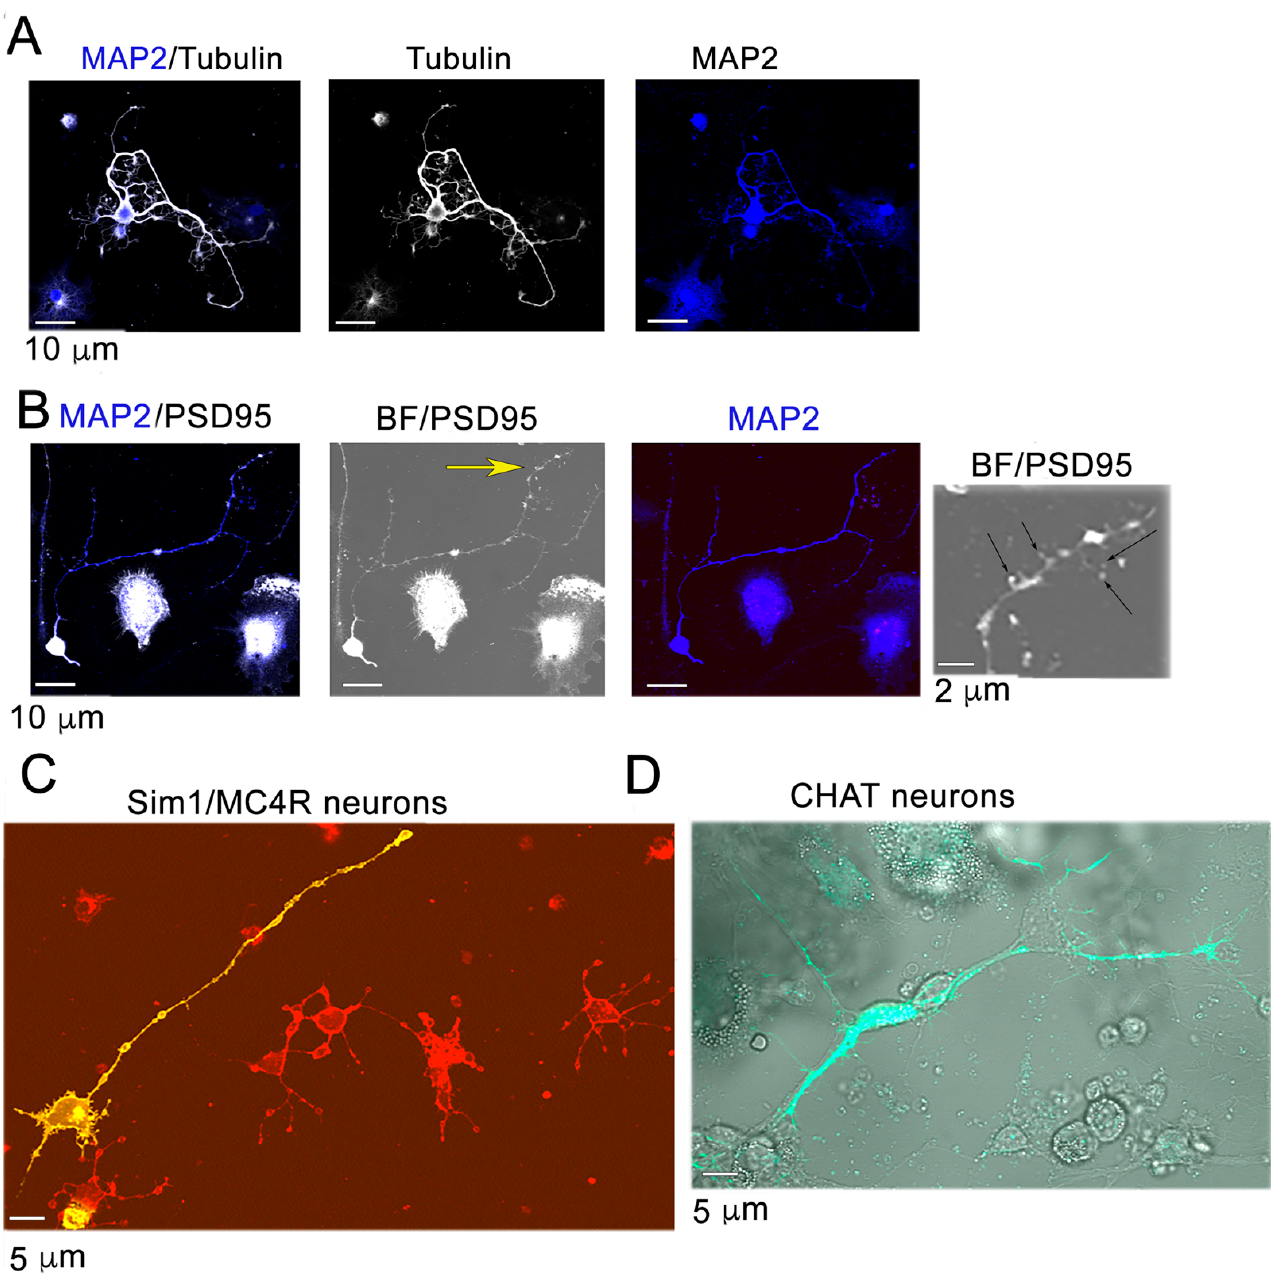
Figure 3. Hypothalamic neurons derived from pre-adult mice extend dendrites with post-synaptic specialization and including subpopulations of Sim1 neurons and cholinergic neurons. ( A ) Primary cultures derived from murine hypothalamus were immunostained with anti-MAP2 (blue fluorescence) and anti- α - tubulin (white fluorescence). ( B ) Cells as in Panel ( A ) were immunostained with anti-MAP2 (blue fluorescence) and anti-PSD95 antibodies (white fluorescence). BF, bright-field microscopy. Yellow arrow indicates region shown at higher magnification. Black arrows indicate PSD95 accumulations at spines. ( C ) The primary culture is derived from Sim1-Cre: Rosa-mEGFP mice to visualize Sim1/MC4R neurons (yellow neurons). ( D ) The primary culture is derived from ChAT-IRES-Cre:CAMPER mice to visualize cholinergic neurons (green neuron).